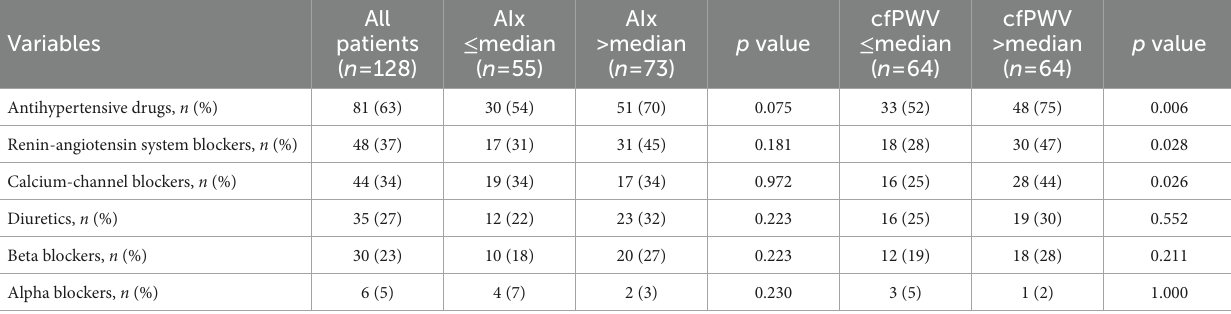
TABLE 2 Use of antihypertensive drugs in the study hypertensive patients who were grouped according to the median value of the Augmentation Index (AIx) and carotid-femoral pulse wave velocity (cfPWV).